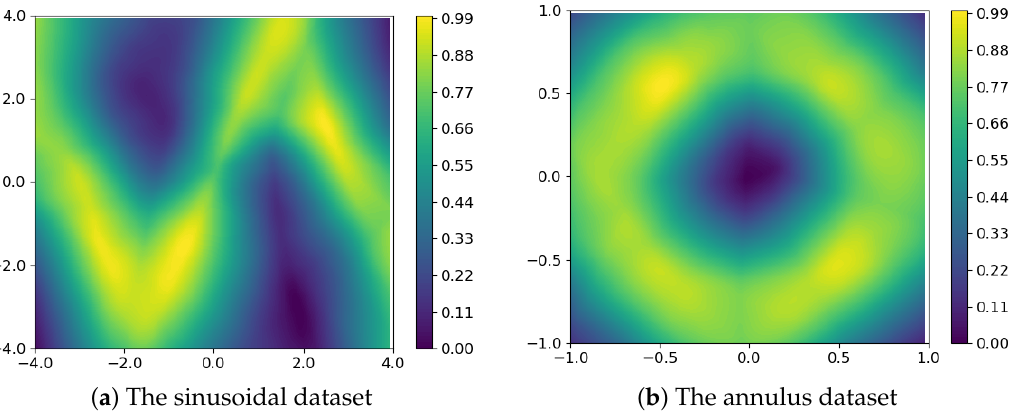
Figure 8. Contour plots showing the values of the two critics for the sinusoidal and annulus datasets. These indicate the confidence in or reliability of the predictions and also indicate where extra training data may be